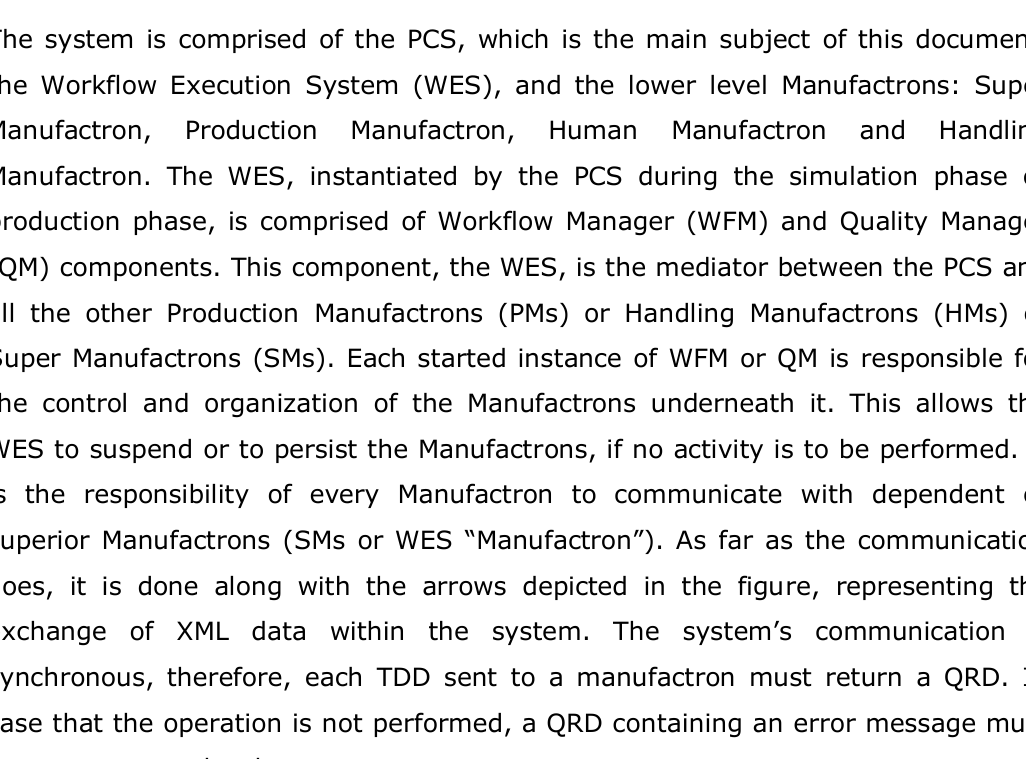
Figure 2. Overview of the manufactronic architecture (Almeida et al.,